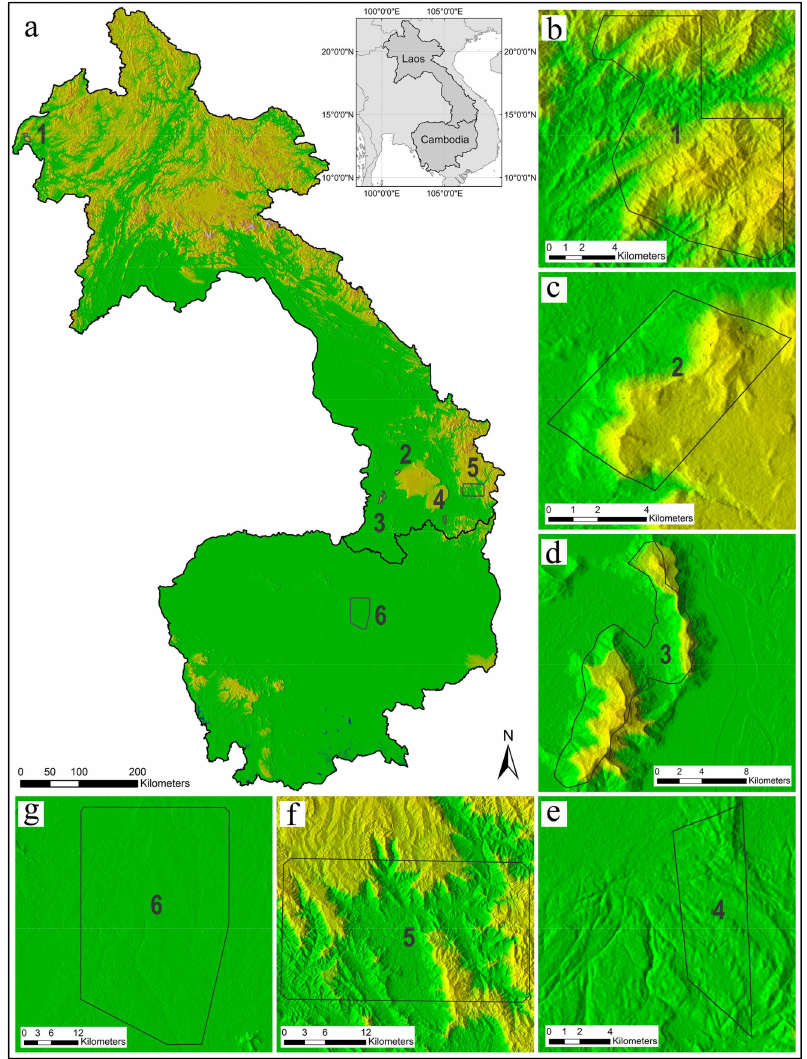
Figure 1. Location and topography of study sites. ( a ) Topography of Laos and Cambodia (based on Shuttle Radar Topography Mission (SRTM) data, visualization using a modified GEE script by Noel Gorelick, green = lower elevation, yellow = higher elevation); black polygons = location of six reference sites. ( b – g ) Detailed topographic situations of individual